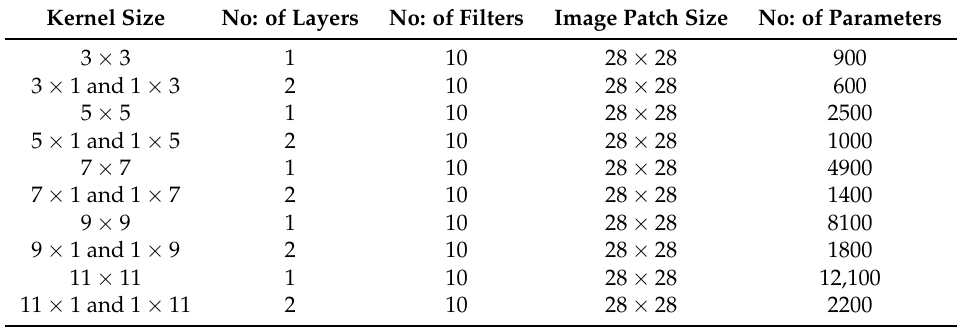
Table 1. Comparison of standard and asymmetric convolution in terms of kernel size and number of parameters. Kernel Size No: of Layers No: of Filters Image Patch Size No: of